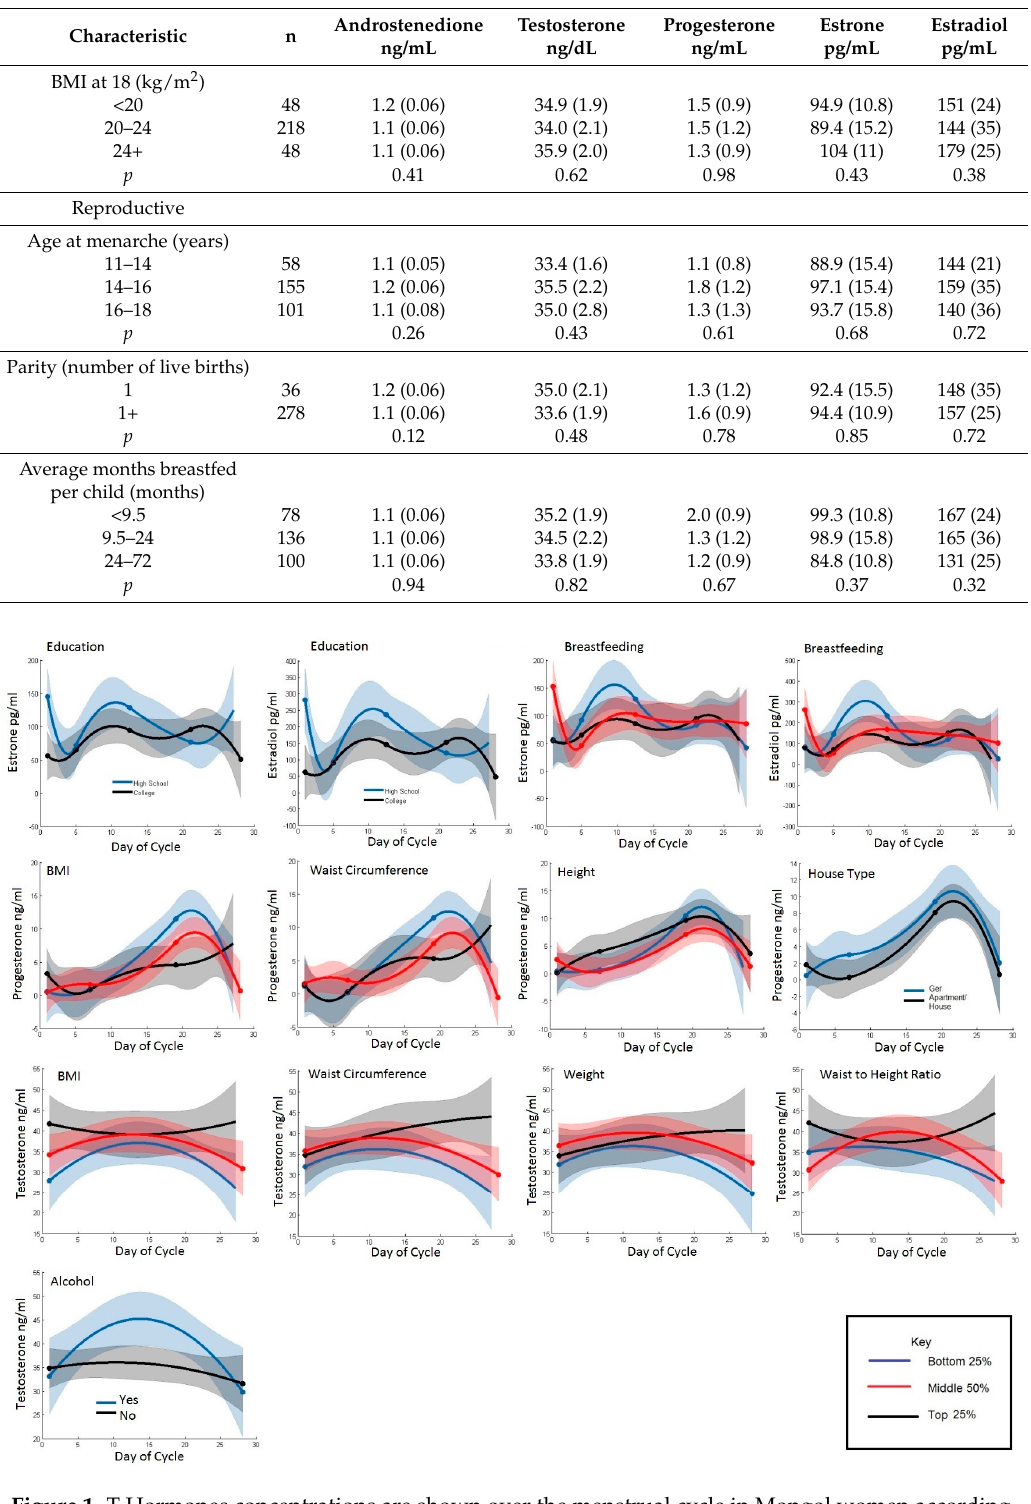
Figure 1. T Hormones concentrations are shown over the menstrual cycle in Mongol women according to different lifestyle (education, ger and alcohol), reproductive (breastfeeding) and anthropometric (BMI, waist circumference, height, weight, waist-to-height ratio). Distributions of the risk factors are cut into the top 25% (black), the middle 50% (red), and the bottom 25% (blue). Estrone and estradiol are shown in row 1, progesterone is shown is row 2, and testosterone is shown in rows 3 and